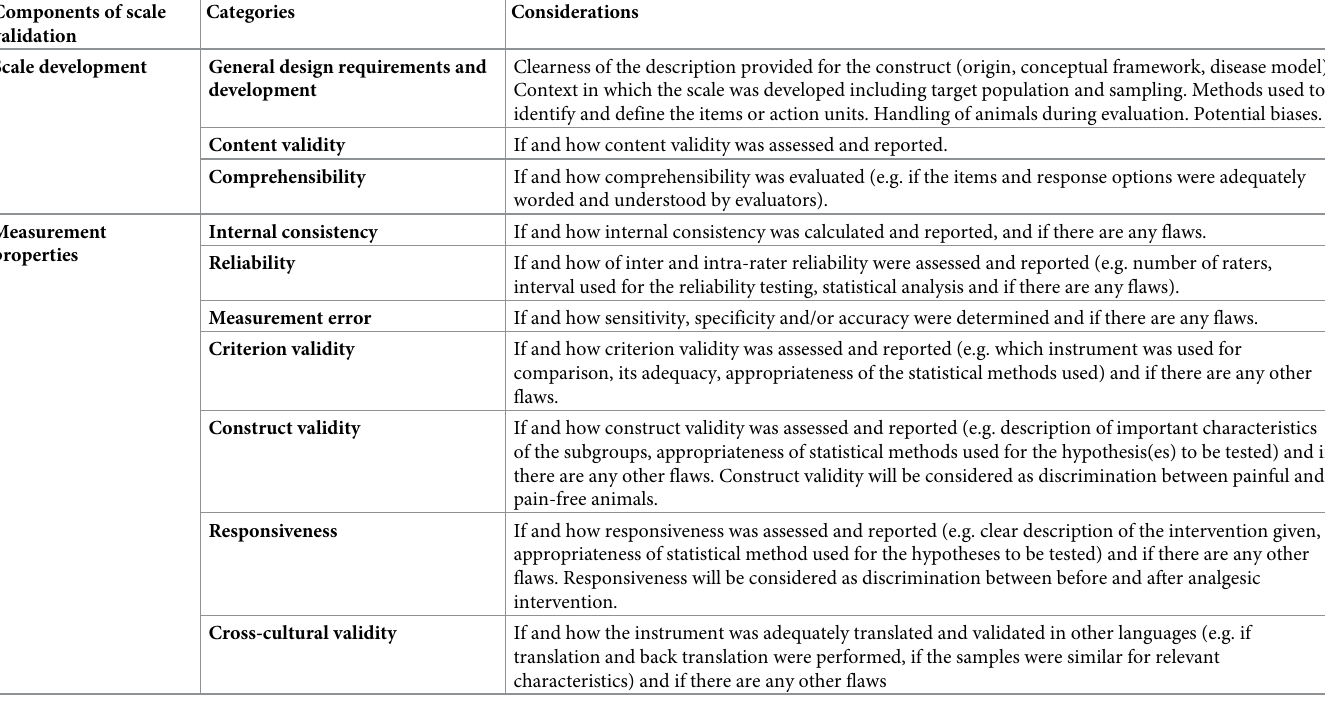
Table 1. General overview of the criteria used for assessment of methodological